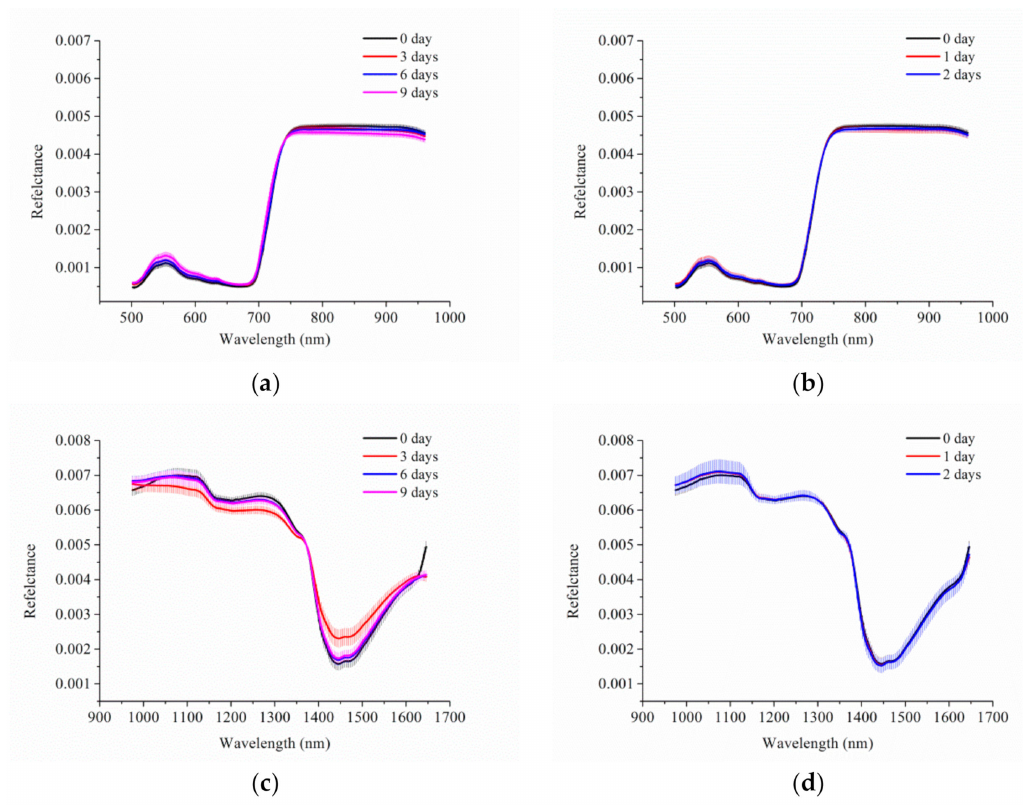
Figure 2. The average spectra with standard deviation (SD): visible / near-infrared (Vis-NIR) hyperspectral images of spinach leaves stored at ( a ) 4 ◦ C and ( b ) 20 ◦ C; NIR hyperspectral images of spinach leaves stored at ( c ) 4 ◦ C and ( d ) 20 ◦